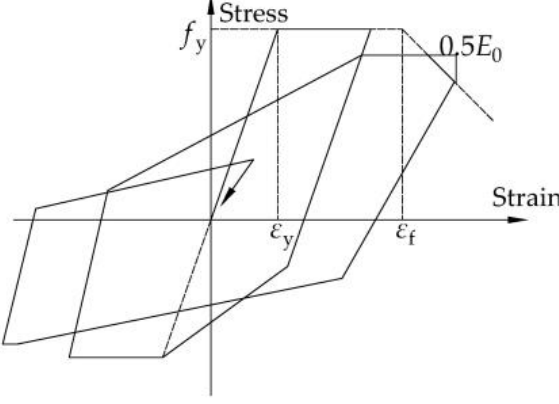
Figure 25. Stress – strain curves of USteel02 of PQ-fiber. Figure 25. Stress–strain curves of USteel02 of PQ-fiber.